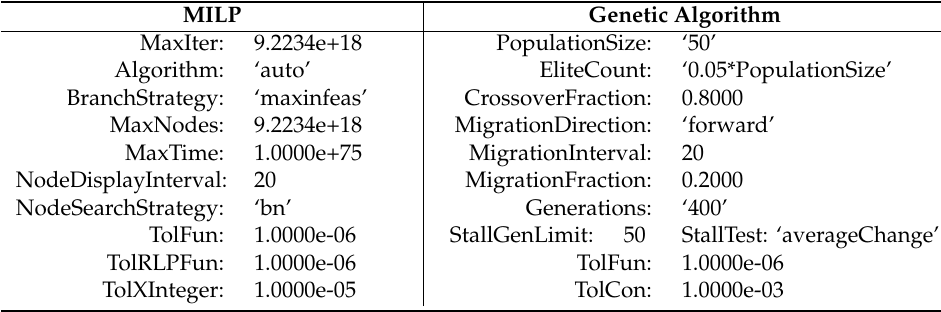
Table 1. Settings and parameters for the optimization algorithms.